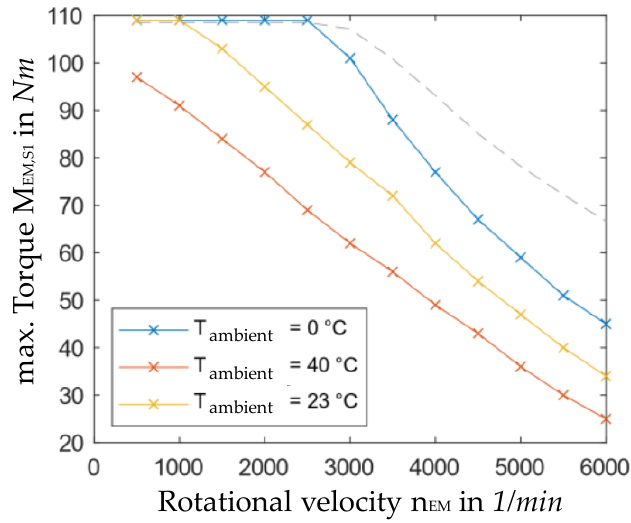
Figure 10. Impact of the ambient temperature on the thermal behavior.